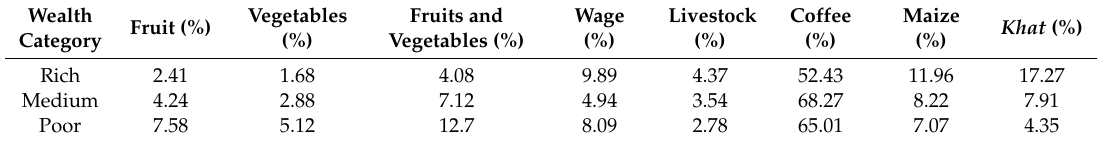
Table 2. Percentage share of income from different income sources for wealth